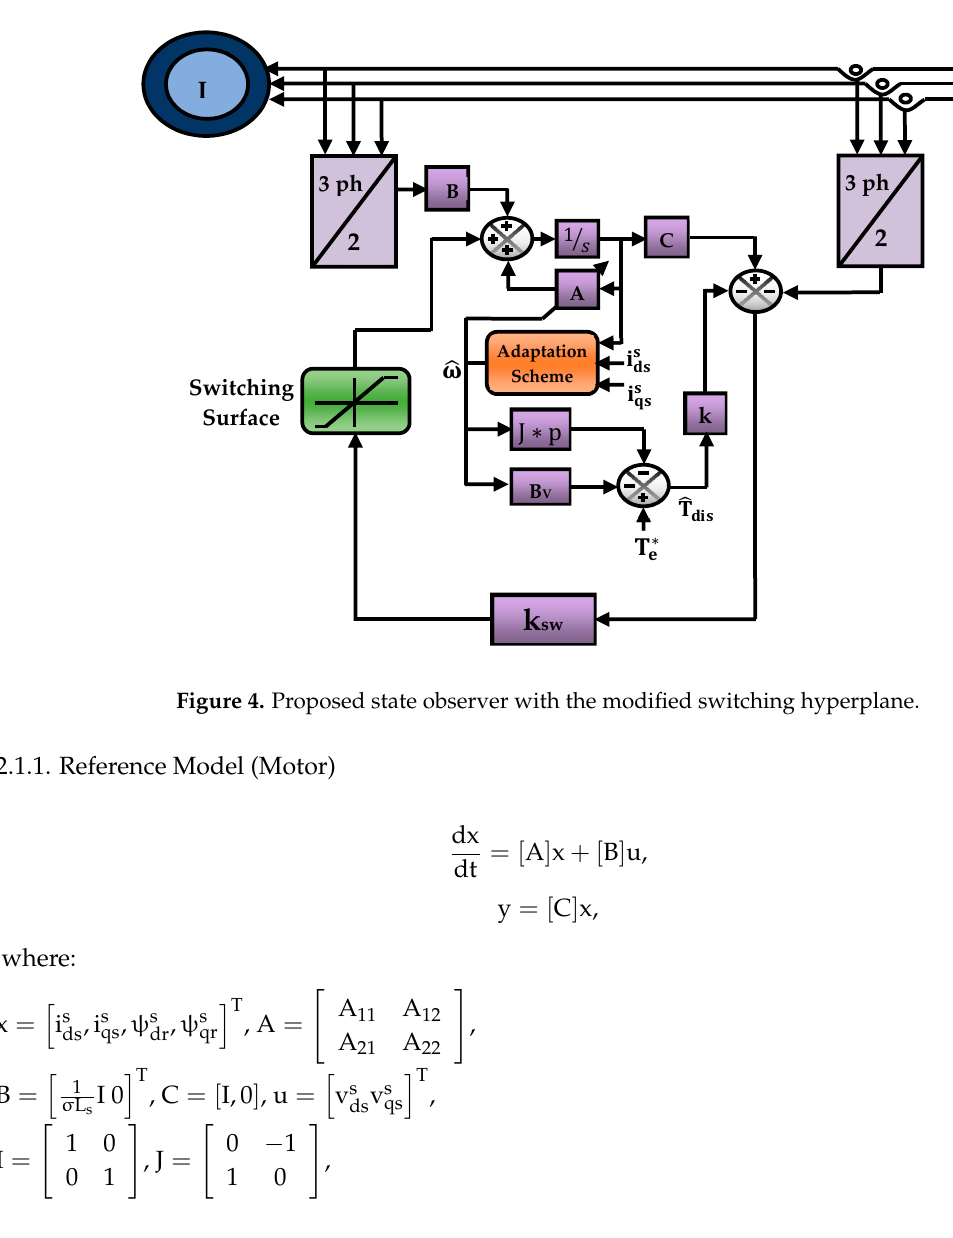
Figure 5. Voltage source inverter (VSI) fed speed sensorless induction motor drive system.